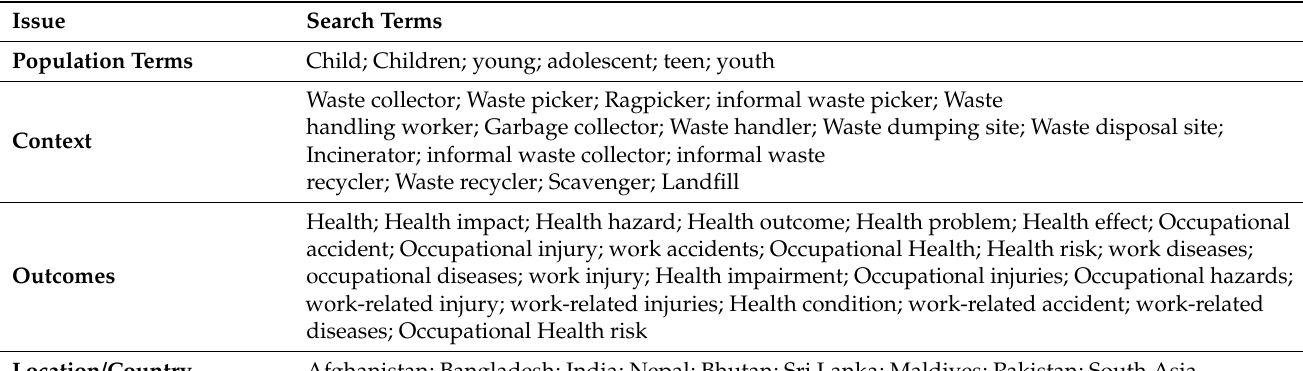
Table 2. Scoping review search